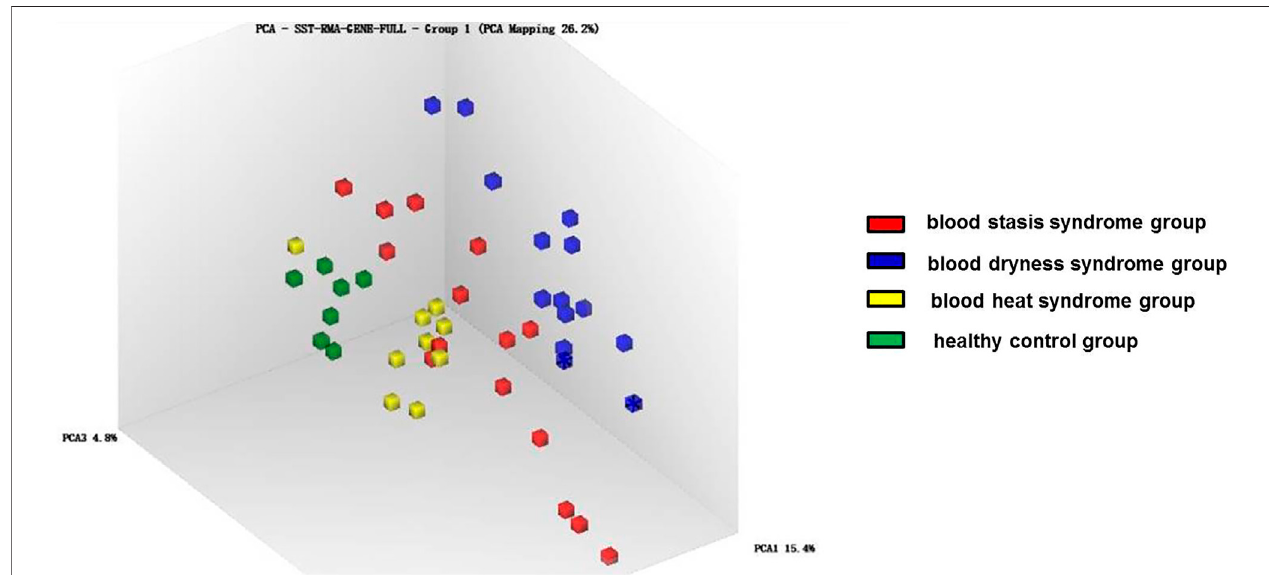
FIGURE 2 | Principal component analysis of gene expression in different